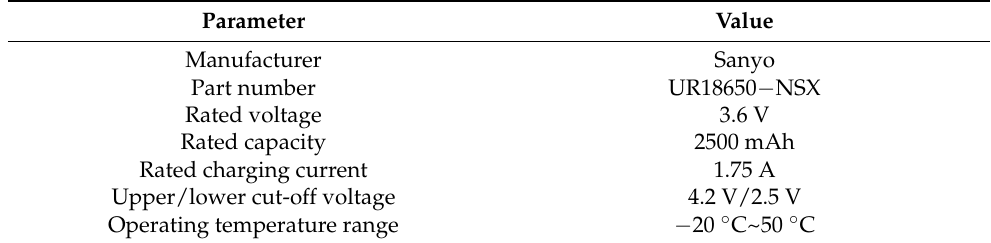
Table 1. Cell specifications used in this